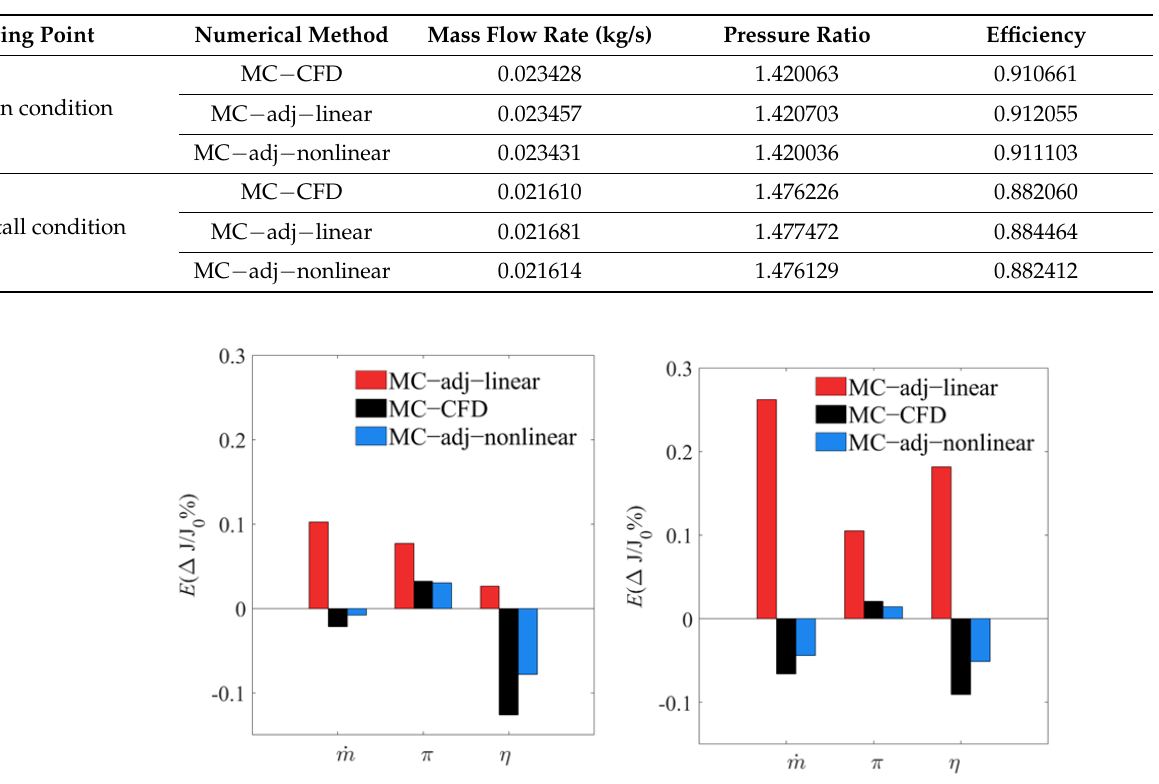
Table 1. The mean aerodynamic performance computed using the three methods at the design and near-stall points.